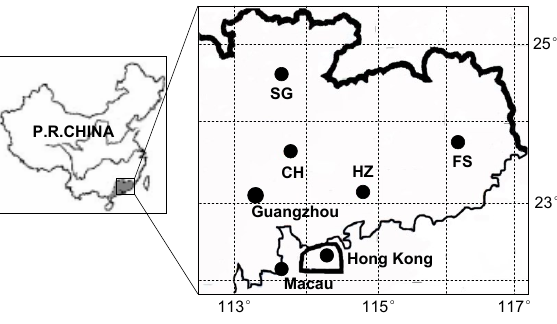
Figure 1. Location of sampling sites and the main cities in the Pearl River Delta in South